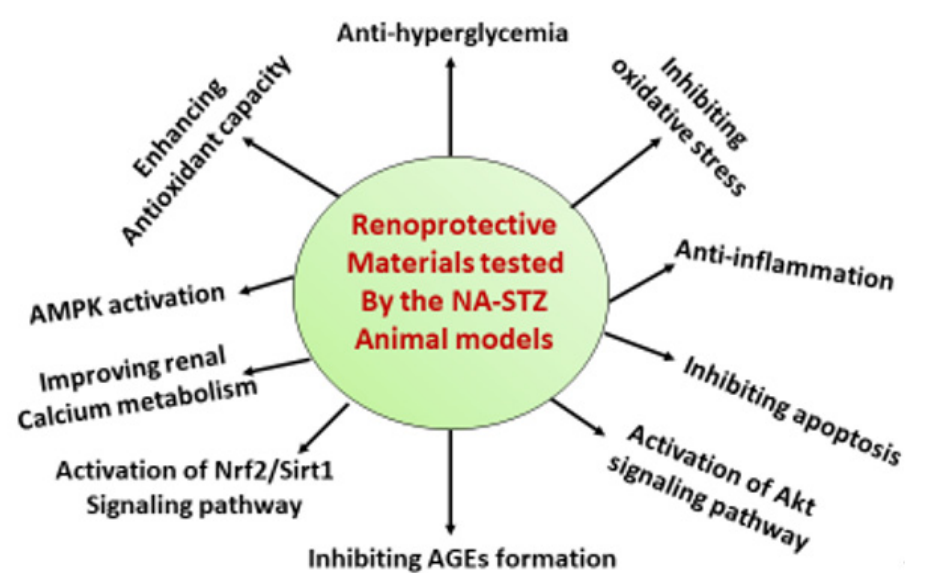
Figure 5. Diagram summarizing the representative renoprotective mechanisms of the materials listed in Table 3, using the NA-STZ non-obese type 2 diabetes animal models. AGEs stands for “advanced glycation end products”. Table 3. Renoprotective materials tested by the NA-STZ type 2 diabetes animal models.